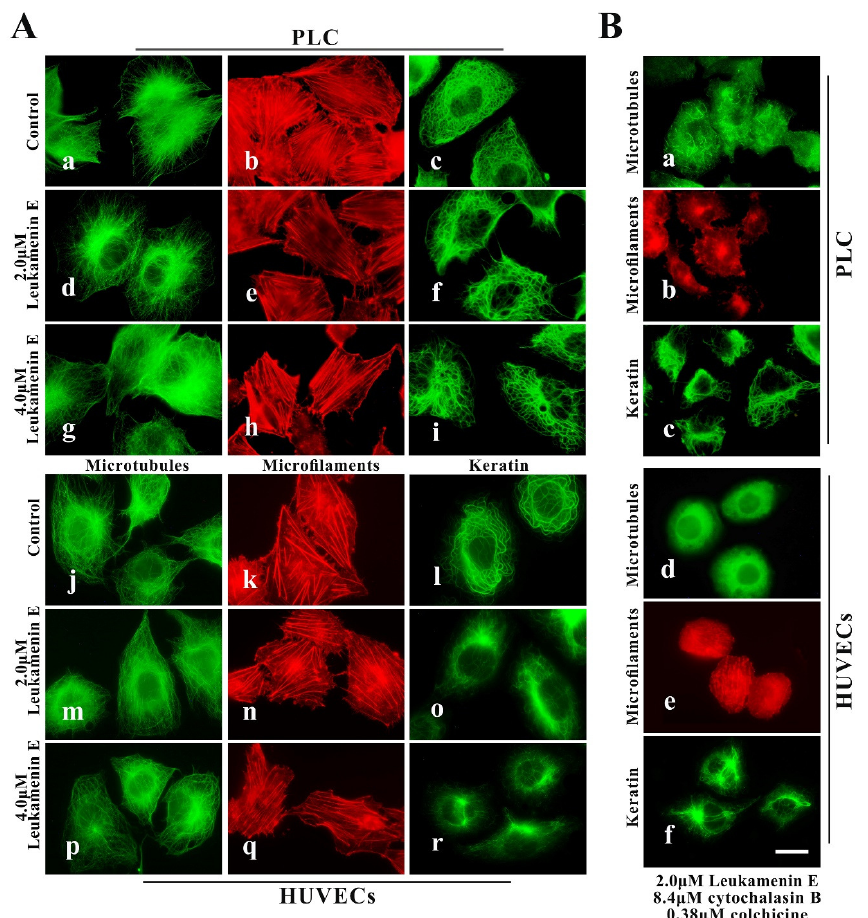
Figure 4. Leukamenin E destroys the KF network in HUVECs and PLC. ( A ) Representative images of cell morphology and three cytoskeleton components in well-spread HUVECs and PLC treated with 2.0 μM leukamenin E (d,m,e,n,f,o) or 4.0 μM leukamenin E (g,p,h,q,i,r) or DMSO (control, a,j,b,k,c,l) for 24 h, showing that leukamenin E destroys the KF network (f,I,o,r) but slightly alters MFs (e,h,n,q) and MTs (d,g,m,p). 1000×, Bar, 10 μm. ( B ) Representative images of cell morphology and three cytoskeleton components in well-spread HUVECs and PLC treated with a combination of leukamenin E, cytochalasin B, and colchicine for 24 h, showing that leukamenin E destroys the KF network (c,f) independently of MFs (b,e) and MTs (a,d). 1000×, Bar, 10 μm. Images represent typical cells from at least three independent experiments.